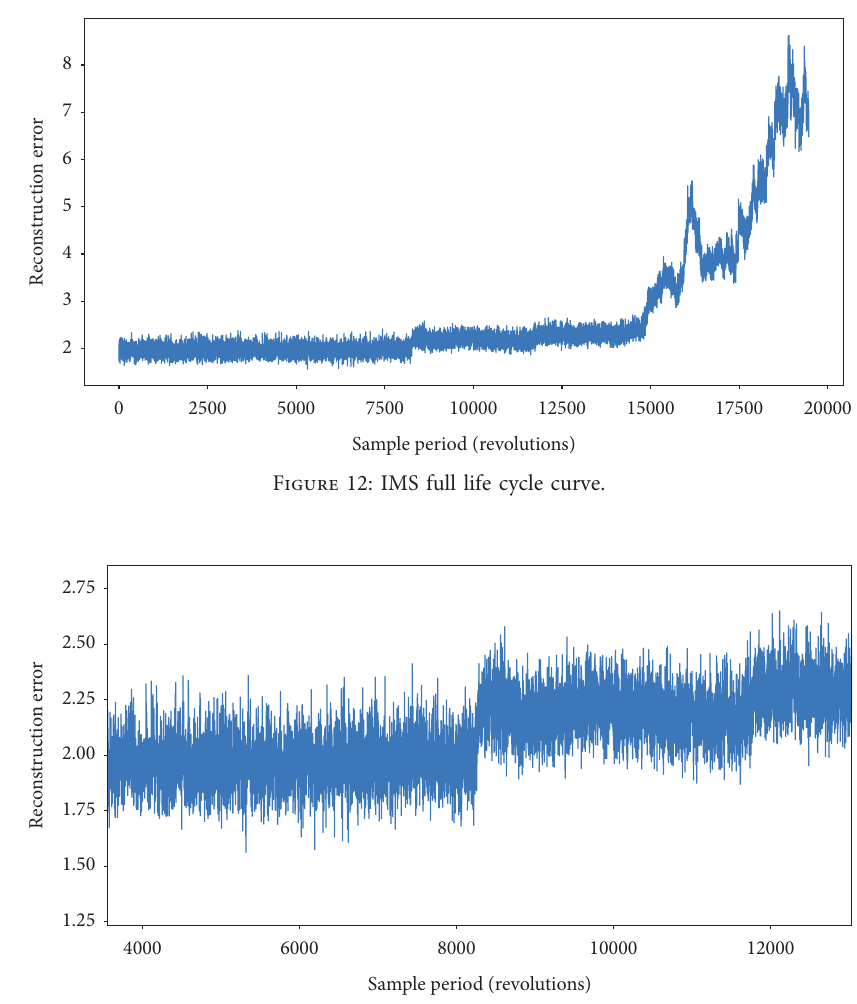
Figure 13: Local enlargement between sample periods 4000 and 12000.